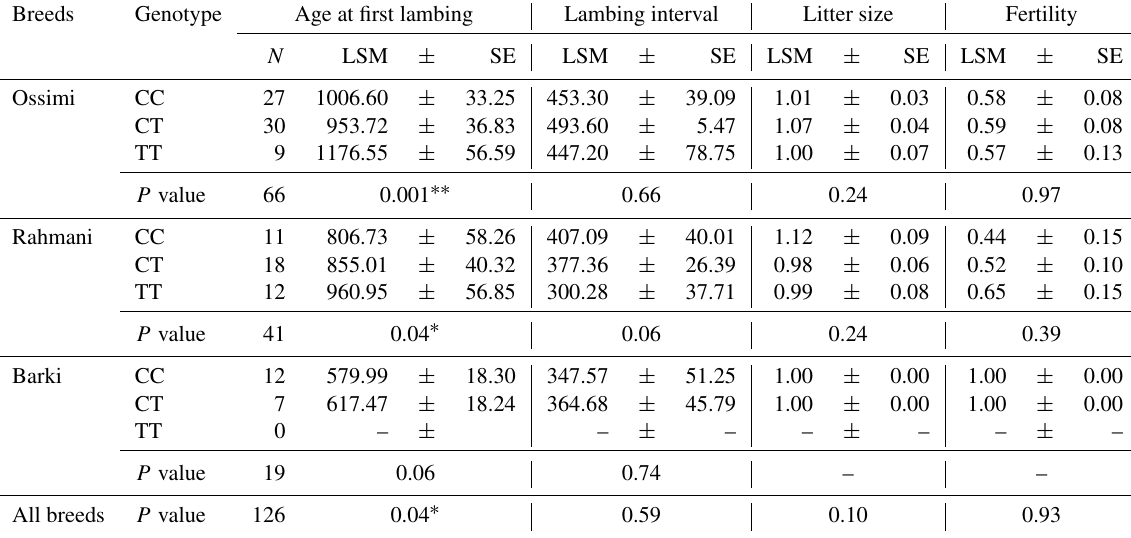
Table 3. Effect of the MTNR1A SNP on reproductive traits in Egyptian sheep breeds. Where is the number of observed genotypes; LSM represents least-square mean; SE represents standard error; N is the number of observed genotypes. Breeds Genotype Age at first lambing Lambing interval Litter size